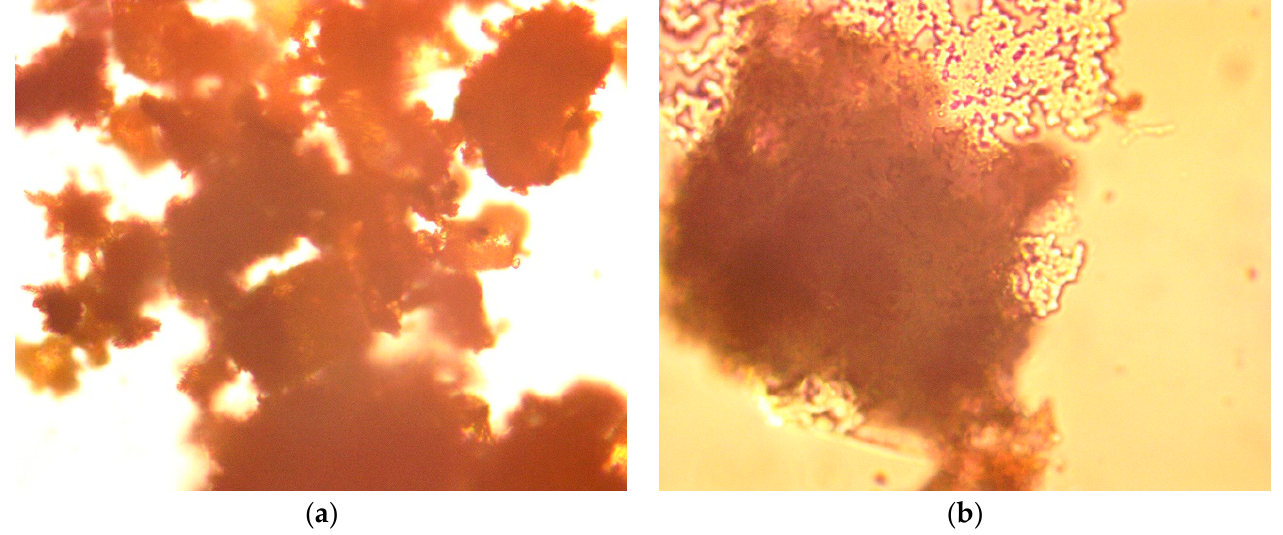
Figure 22. Transmitted light photomicrographs of the ZVI from the cartridge after it had processed 70 batches of water. ( a ) Iron fibres converted to a network of hydrated iron ‐ oxyhydroxides. Field of view = 1 mm. ( b ) Iron oxyhydroxide, following air drying, showing mobile NaCl removed from the intra ‐ particle porosity within the layered double hydroxides, constituting part of the iron oxyhydroxide. Field of view = 0.4 mm.